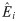
Myeloid cell differentiation network.(A) Graph shows the subnetwork of differential genes largely involved in myeloid cell differentiation. Color encodes the value of the integrative statistic from green (upregulated in AD) to red (downregulated in AD). Squares indicate significantly differential genes (99% credible interval). The gene NFIC is represented twice reflecting two alternative active promoters. (B) Boxplots depict the transcription levels of the subnetwork’s genes in each of five major brain cell types obtained from an external RNA-seq dataset of purified cell types. (C) Table shows the value of the integrative statistic E^i and the unadjusted p-value from the two external validation datasets for each significant gene in the subnetwork. The directionality in the validation studies (up- or downregulated in AD) is given if the p-value was less than 0.1.